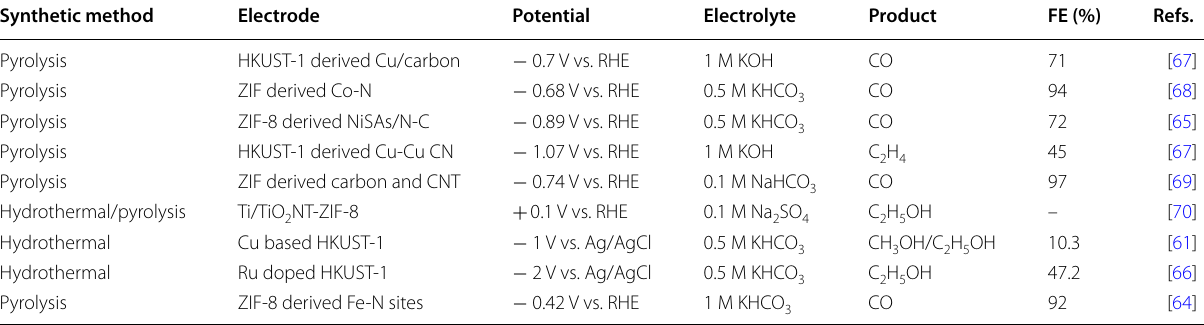
RR reduction using MOF‑derived materials 2